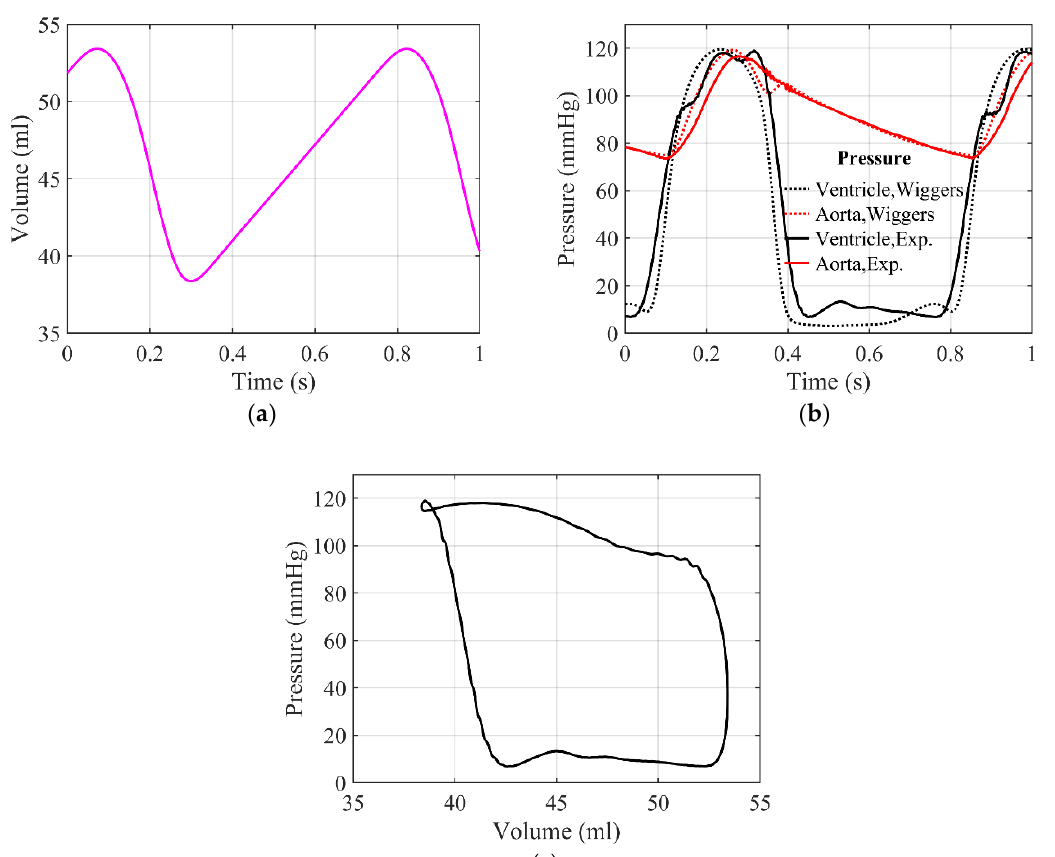
Figure 8. Baseline experiment result: ( a ) volume waveform; ( b ) pressure waveforms; ( c ) ventricular pressure × 10—volume loop of mock circulatory platform.